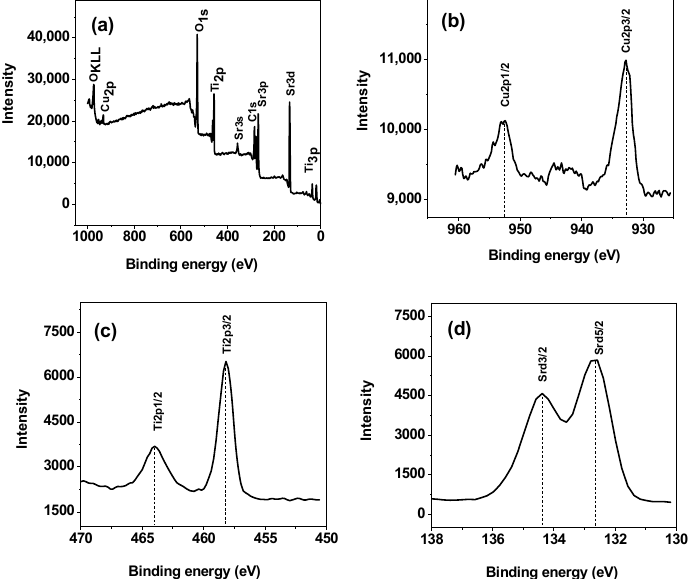
Figure 3. XPS spectra of the samples: ( a ) XPS survey spectrum of 1.5% CuO ‐ SrTiO 3 sample; ( b ) high ‐ resolution Cu 2p spectrum; ( c ) high ‐ resolution Ti 2p spectrum and ( d ) high ‐ resolution Sr d spec ‐ trum.